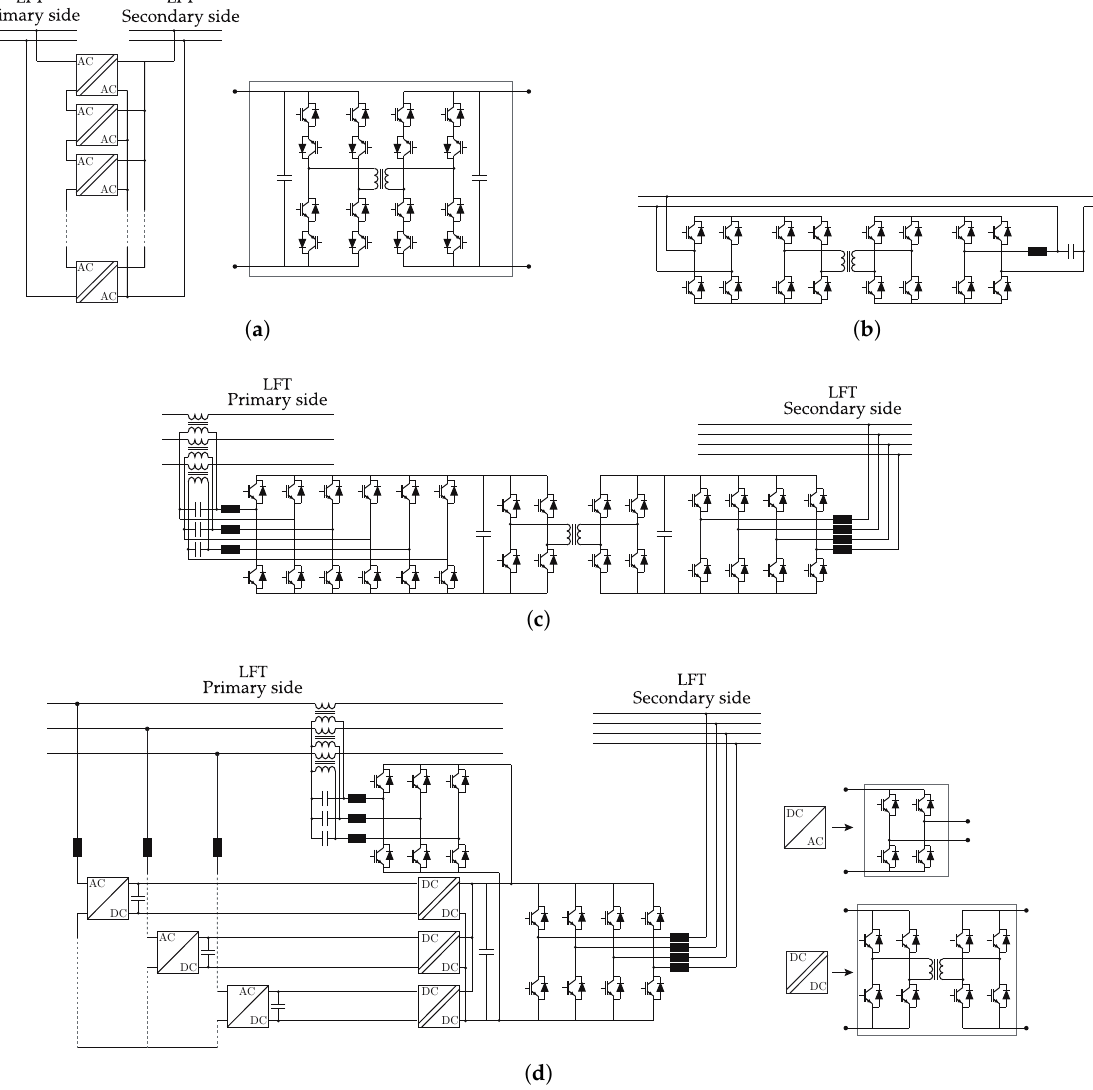
Figure 10. Power converter topologies with galvanic isolation. ( a ) Three-stage power converter with DAB DC/DC converter. ( b ) Three-stage power converter based on a indirect matrix converter. ( c ) Single-stage cascaded AC/AC full-bridges in input series and output parallel (ISOP) configuration. ( d ) Three-stage power converter with dual-active bridge (DAB) in ISOP configuration for series and shunt (four-wire)